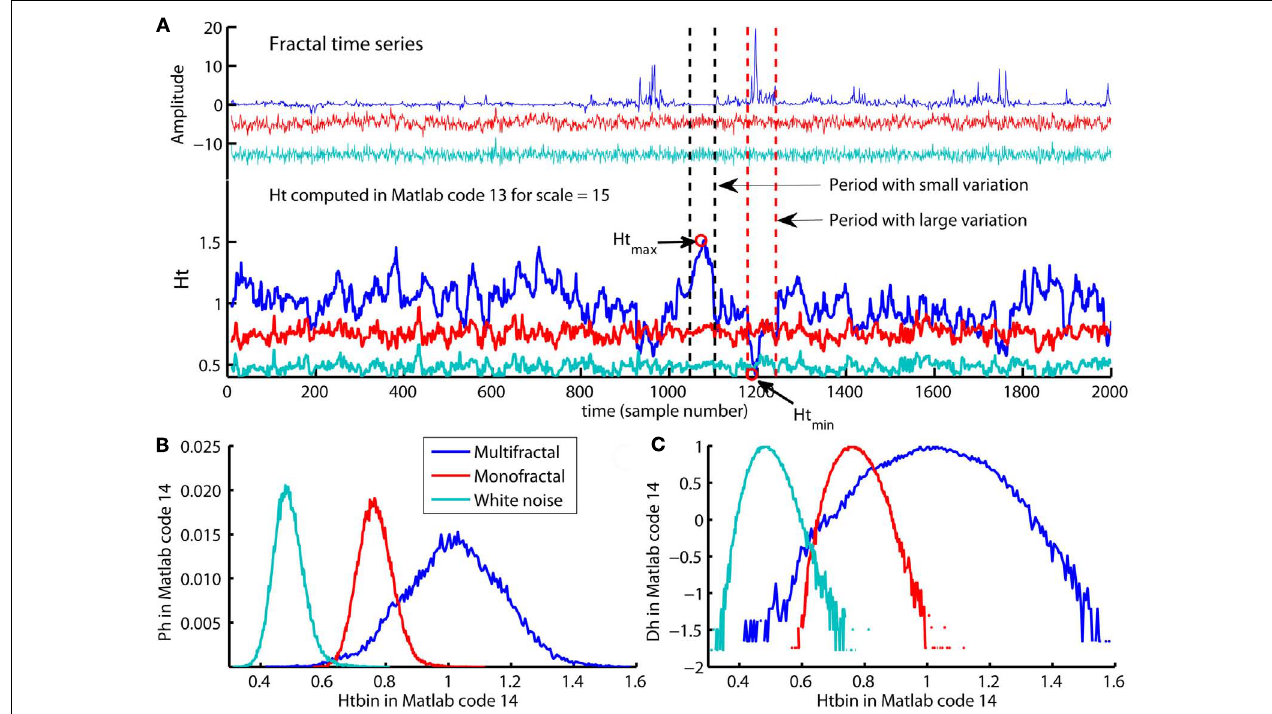
contains the smallest Ht(5,:) (see Ht min in the period between red dashed lines ). (B) The probability distribution Ph of the local Hurst exponents Ht estimated as histograms by Matlab code 14 for the multifractal , monofractal, and whitenoise time series. (C) The multifractal spectrum Dh estimated from distribution Ph by Matlab code 14 for the same time series.The distribution Ph and spectrum Dh have a larger width for the multifractal time series compared to the monofractal and whitenoise time